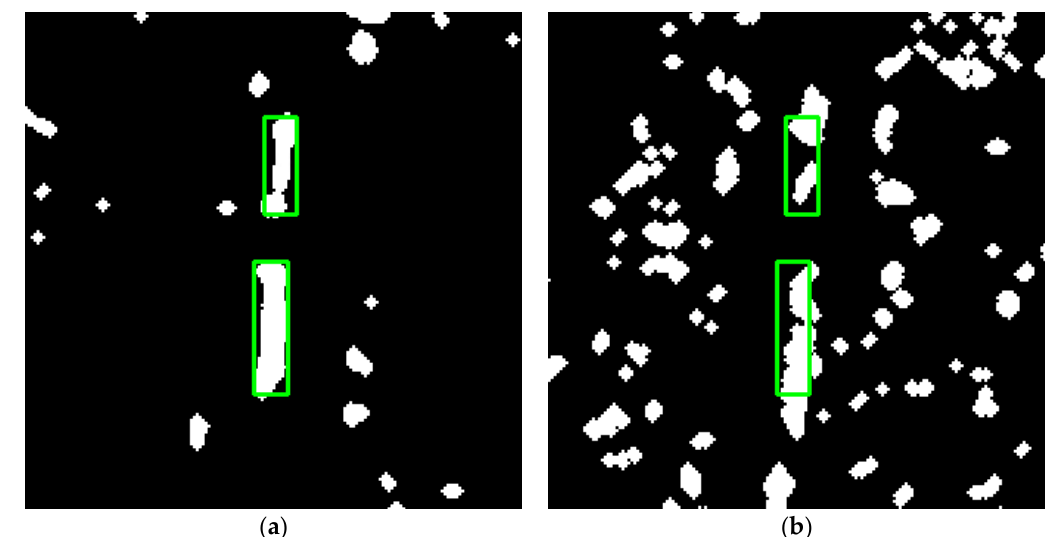
Figure 9. Comparison between the background frame detection algorithm and the multi-interval frame difference algorithm. The green rectangles represent the real position of the shadow of the moving target. ( a ) Result of the background frame detection algorithm. ( b ) Result of the multi-interval frame difference algorithm.